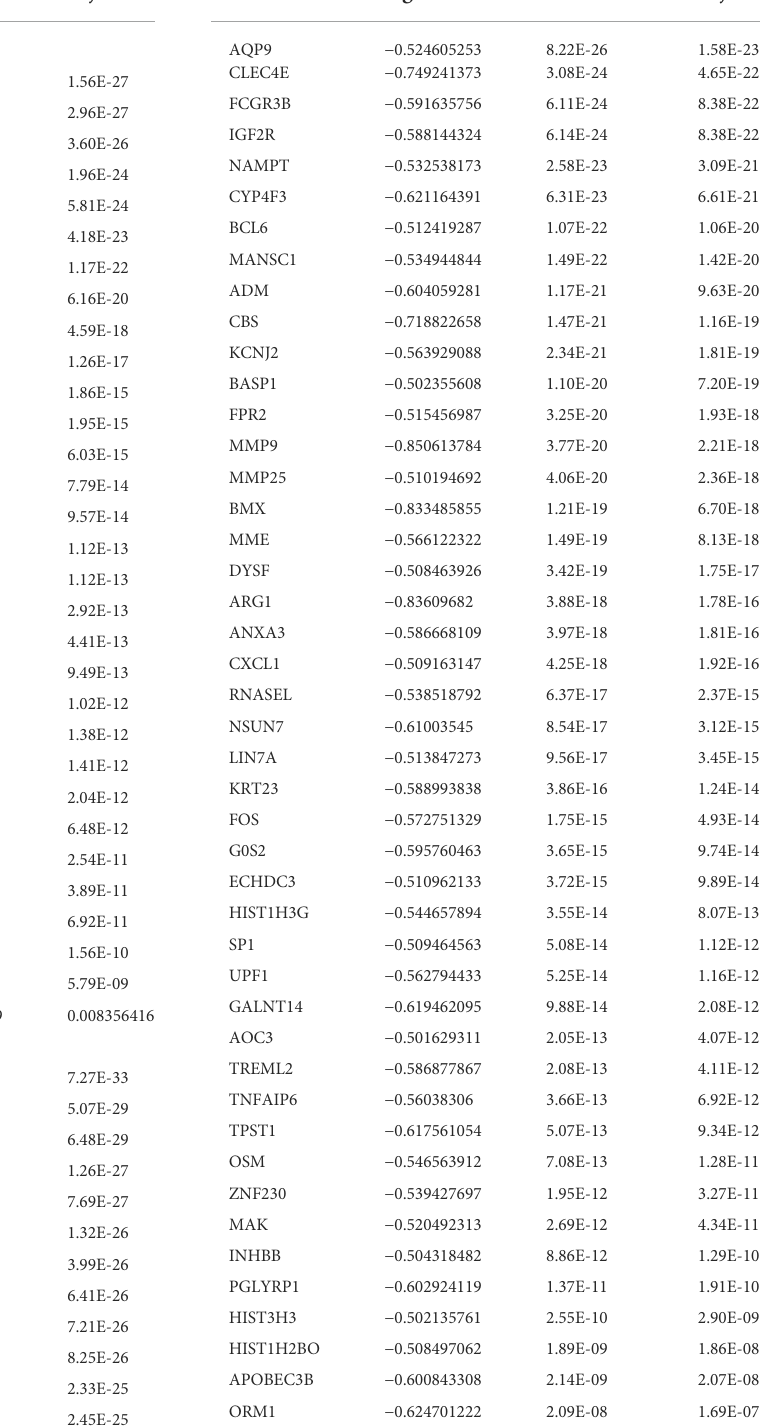
TABLE 1 Differential genes between cluster A and cluster